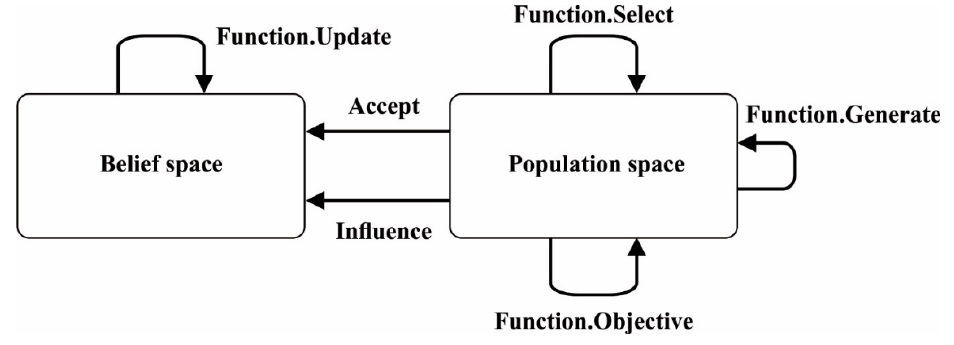
Figure 2. Workflow of CEPO algorithm.